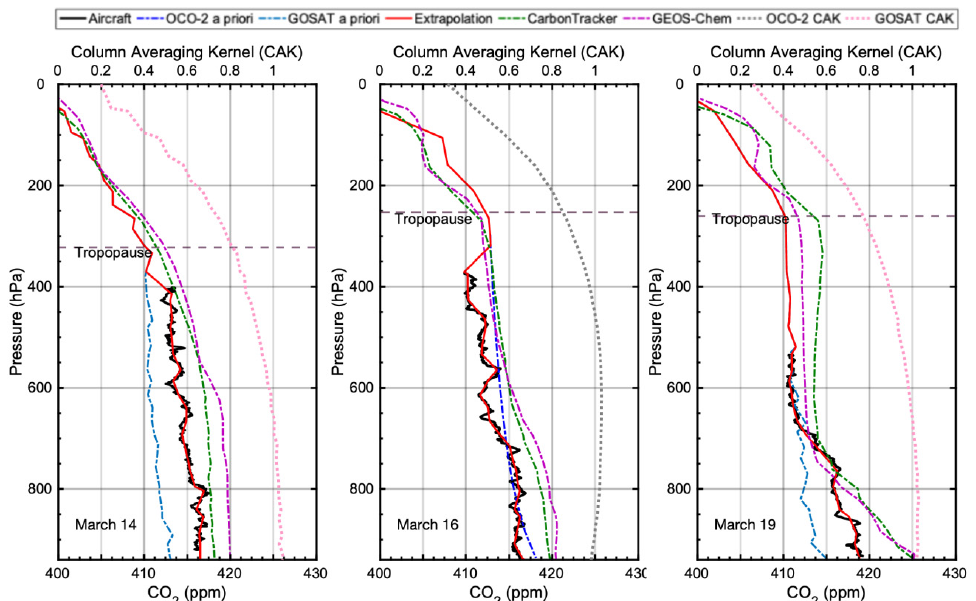
Figure 5. The CO 2 profiles from Aircraft, GEOS-Chem, CarbonTracker, GOSAT, and OCO-2 along with their corresponding column averaging kernels (CAK) for 14, 16, and 19 March 2019 over Qinhuangdao, China. The red line shows the extrapolation of the aircraft measurements using satellite a priori data. The horizontal line represents the tropopause height which was calculated using the National Centers for Environmental Prediction (NCEP) reanalysis dataset [63].